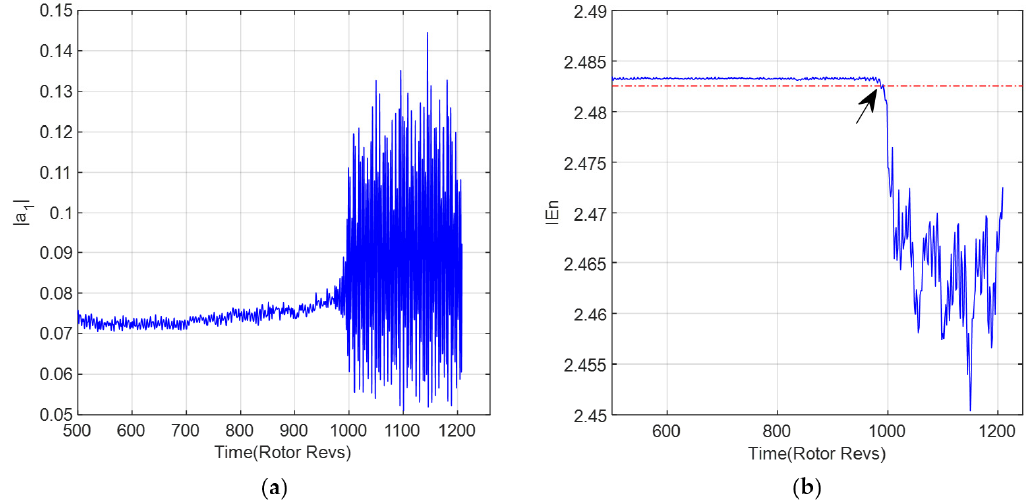
Figure 8. Information entropy of the spatial mode at 2500 rpm: ( a ) First-order space mode; ( b ) Infor- mation entropy.